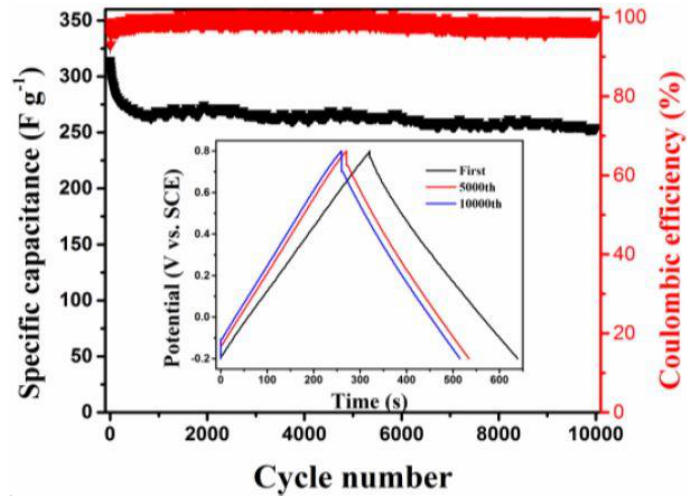
Figure 7. Cycling stability of the MnO 2 /BC electrode at a current density of 1 A g − 1 in 1 M of Na 2 SO 4 electrolyte (the inset shows GCD curves at different cycles).